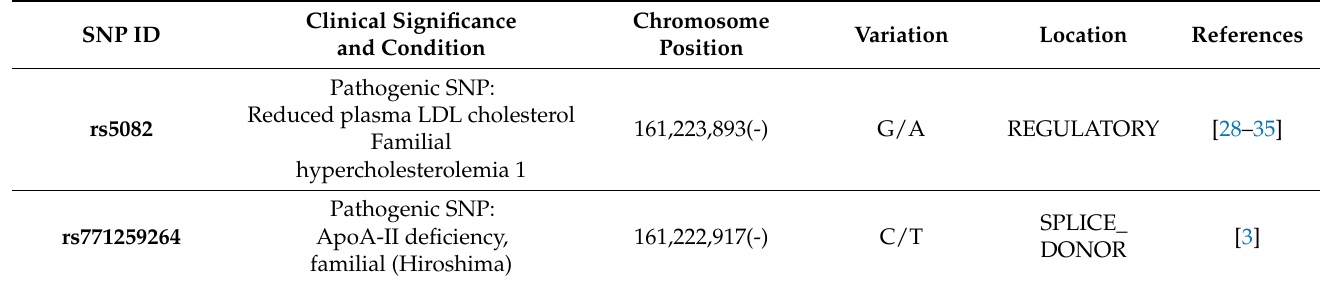
Table 1. Main SNPs of apolipoprotein A-II with confirmed clinical